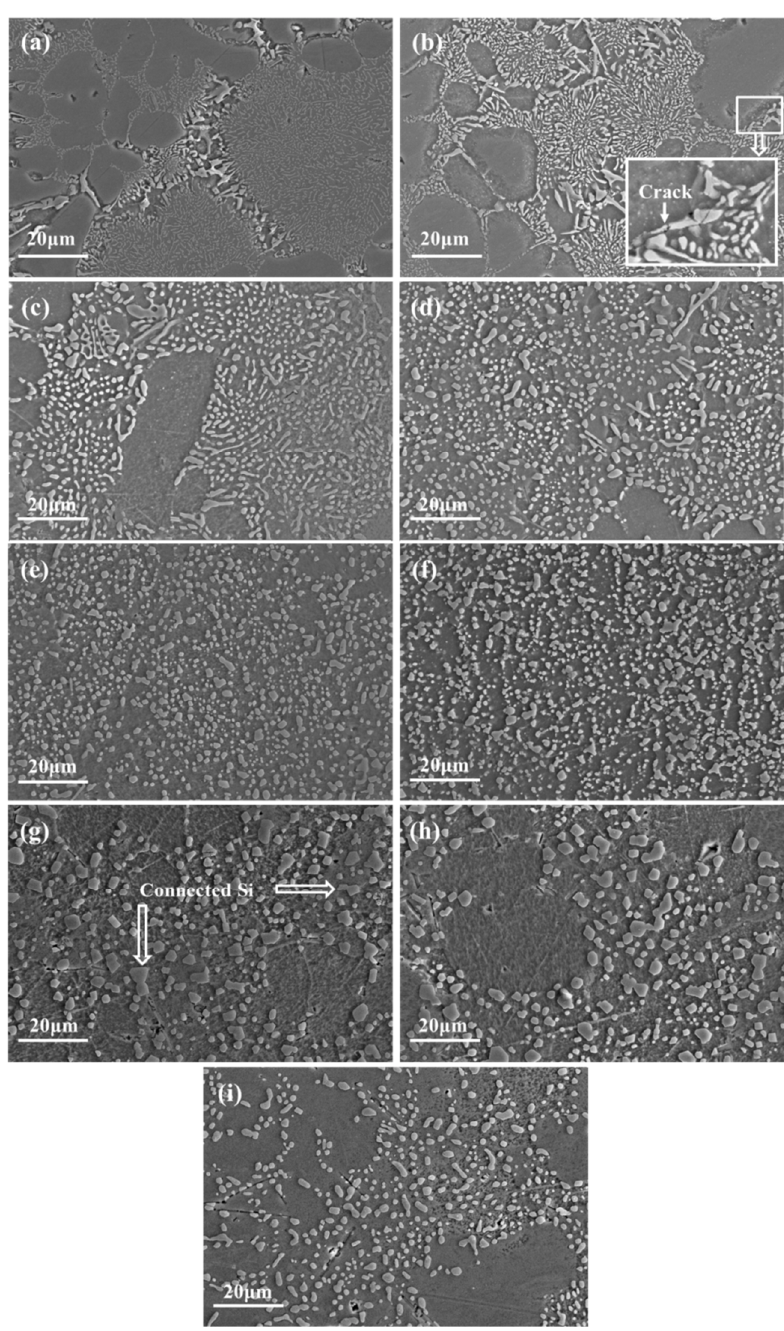
Figure 5. Morphology of eutectic Si under different solution treatment ( a – h : sample formed by squeezing casting; i : sample formed by gravity casting): ( a ) 0 min, ( b ) 15 min, ( c ) 30 min, ( d ) 45 min, ( e ) 60 min, ( f ) 120 min, ( g ) 180 min, ( h ) 240 min, ( i ) 120 min.